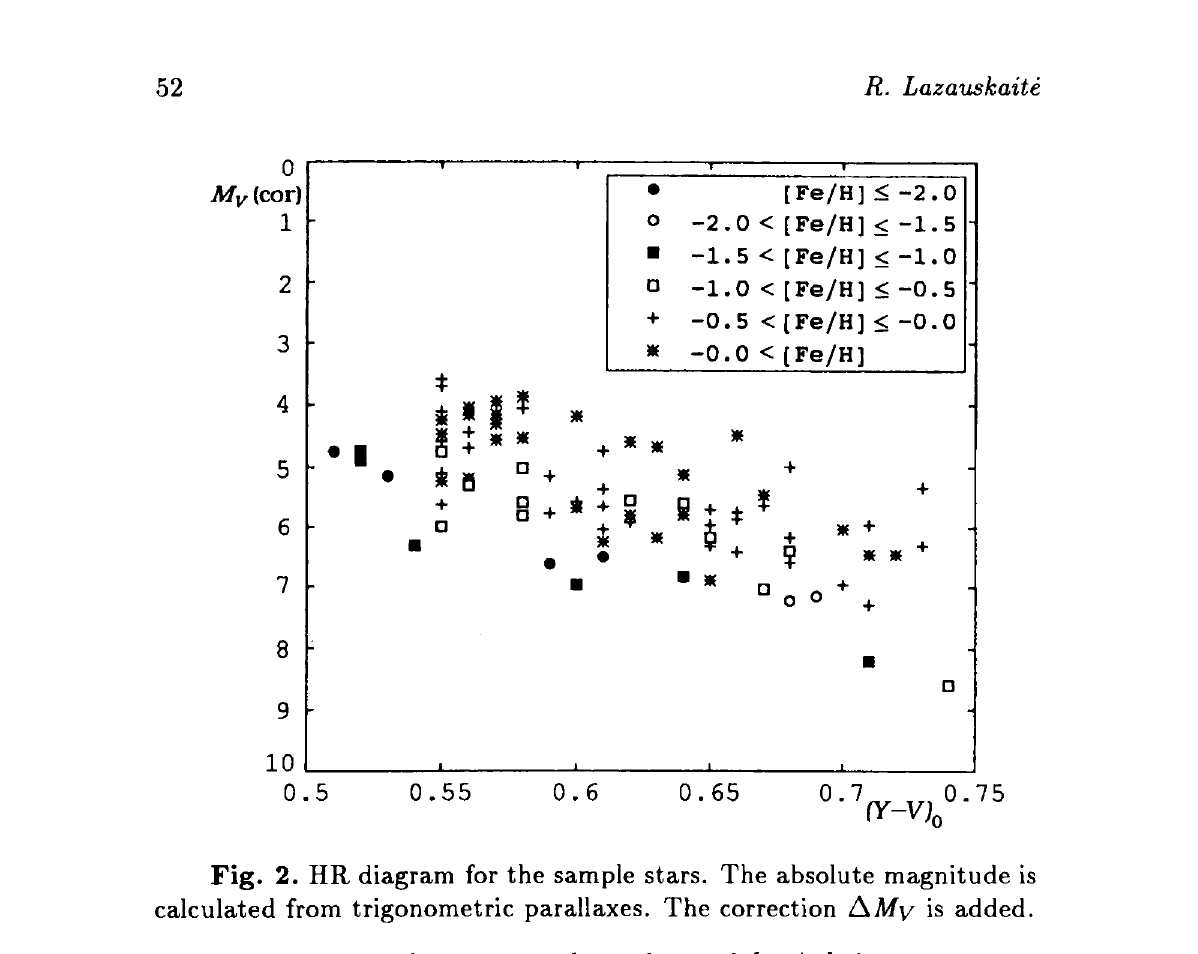
Fig. 2. HR diagram for the sample stars. The absolute magnitude is calculated from trigonometric parallaxes. The correction AA/y is